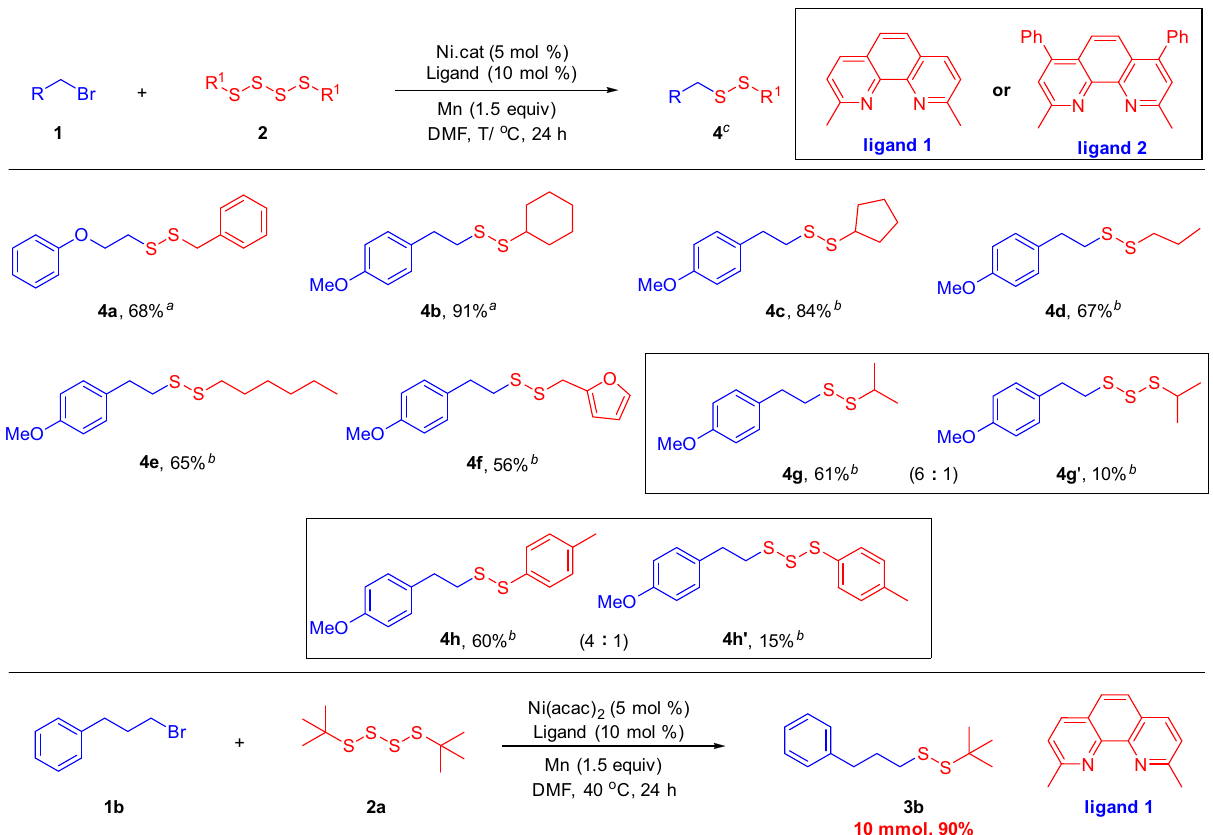
Fig. 4 Scope of tetrasul fi des 2. Reaction conditions: Primary alkyl bromides 1 (0.20 mmol, 1.0 equiv.), symmetrical tetrasul fi des 2 (0.24 mmol, 1.2 equiv.), Mn (0.30 mmol, 1.5 equiv.), DMF (1 mL), N 2 atmosphere. a Ni(acac) 2 (5.0 mol%), L1 (10 mol%); 40 °C, 24 h. b NiF 2 (5.0 mol%), L2 (10 mol%), 80 °C; 24 h. c Isolated